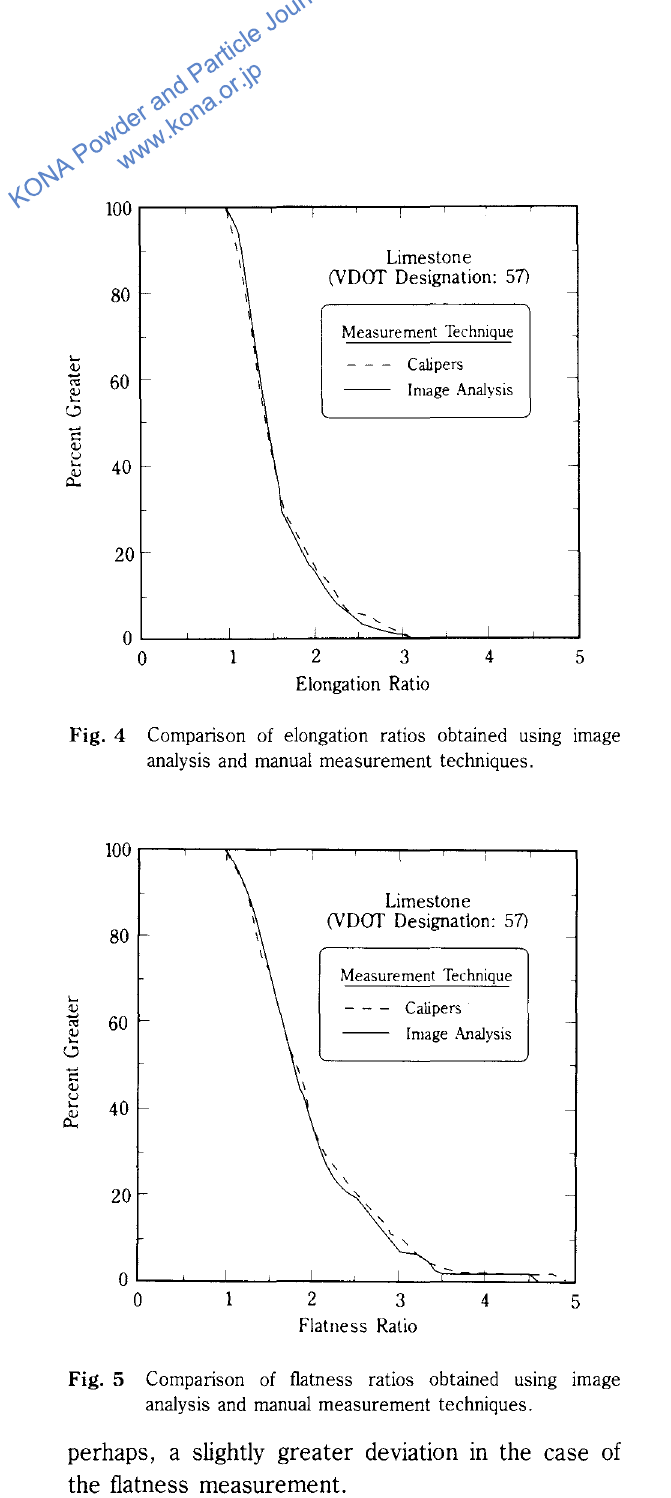
Fig. 5 Comparison of flatness ratios obtained using image analysis and manual measurement